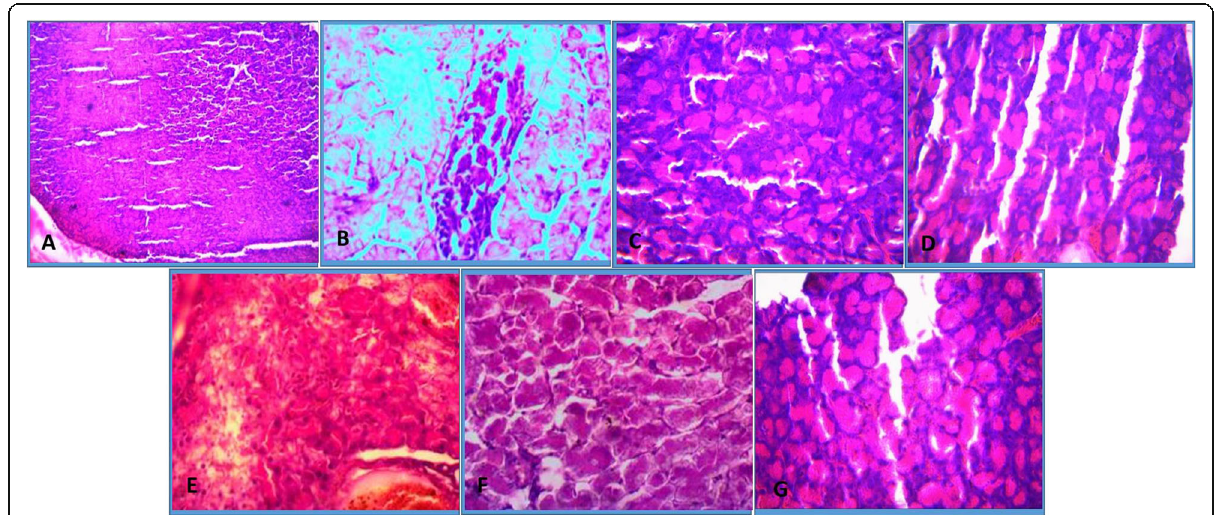
Fig. 6 Photomicrograph slides of rat Pancreas (Hematoxylin and eosin staining, 100x magnification). A: Liver of Diabetic control; B: Liver of Obese diabetic control; C: Liver of Obese diabetic rats treated with 10% Pleurotus tuber-regium ; D: Liver of Obese diabetic rats treated with 20% Pleurotus tuber-regium ; E: Liver of Drug control rats; F: Liver of Obese control rats; G Liver of Normal control